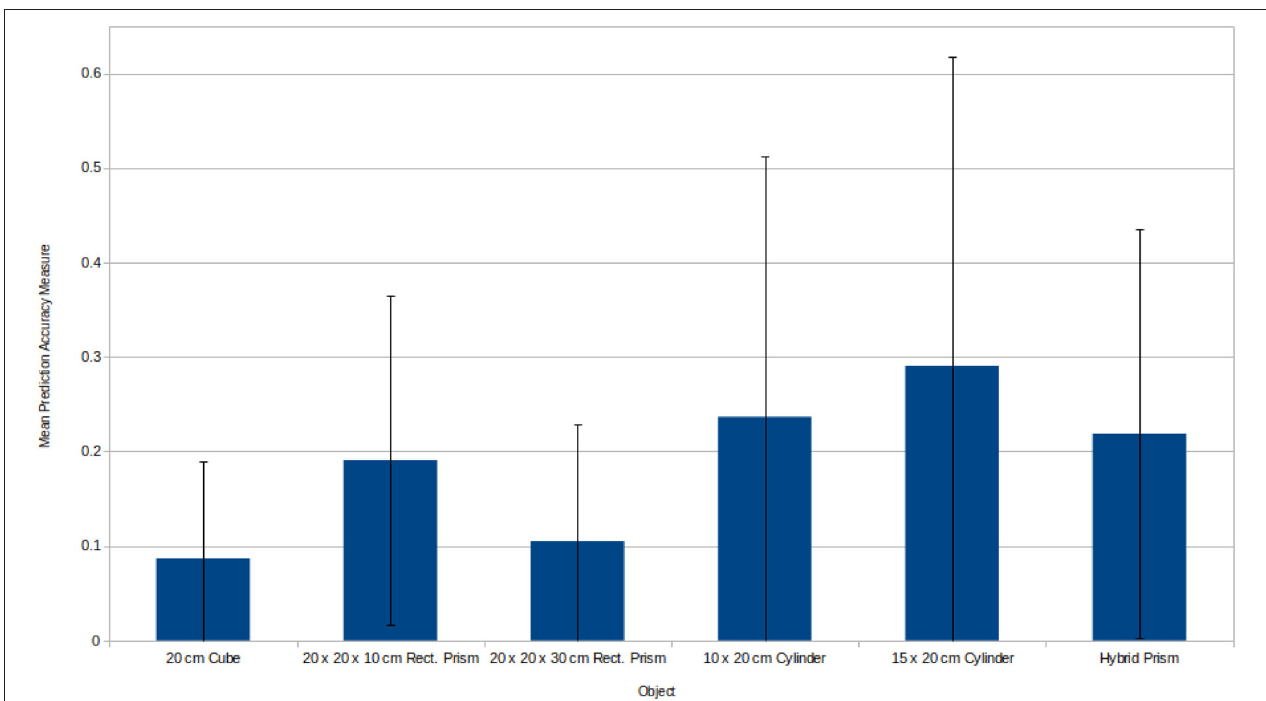
FIGURE 10 | Mean prediction accuracy measures produced during biasing experimentation for each object. The mean is only taken for cases where the prediction time mass/friction conditions match biased training time conditions. This is to ensure that any difference in performance between objects is due to their shape incongruence and not factors relating to friction/mass incongruence or generalisation at training time. Since there is a low, medium, and high biased model for both mass and friction, each with 100 test pushes, the mean prediction accuracy measure is taken over 600 test pushes. The three objects on the left of the figure were executed using a model trained on a 20 cm cube. Meanwhile the three objects on the right of the figure were executed using model trained on a cylinder with height 20 cm and radius 10 cm . Objects tend to give performance similar to the object the model was trained with and the cylindrical objects generally perform worse, revealing a heightened difficulty of predicting for objects with more complex geometries. Finally, in the case of the 10 cm cube, even though it appears to perform half as well as the 20 cm cube upon which its model was trained, it is also half the size and therefore the linear part of its error is doubled, meaning the linear error may well likely be similar between the